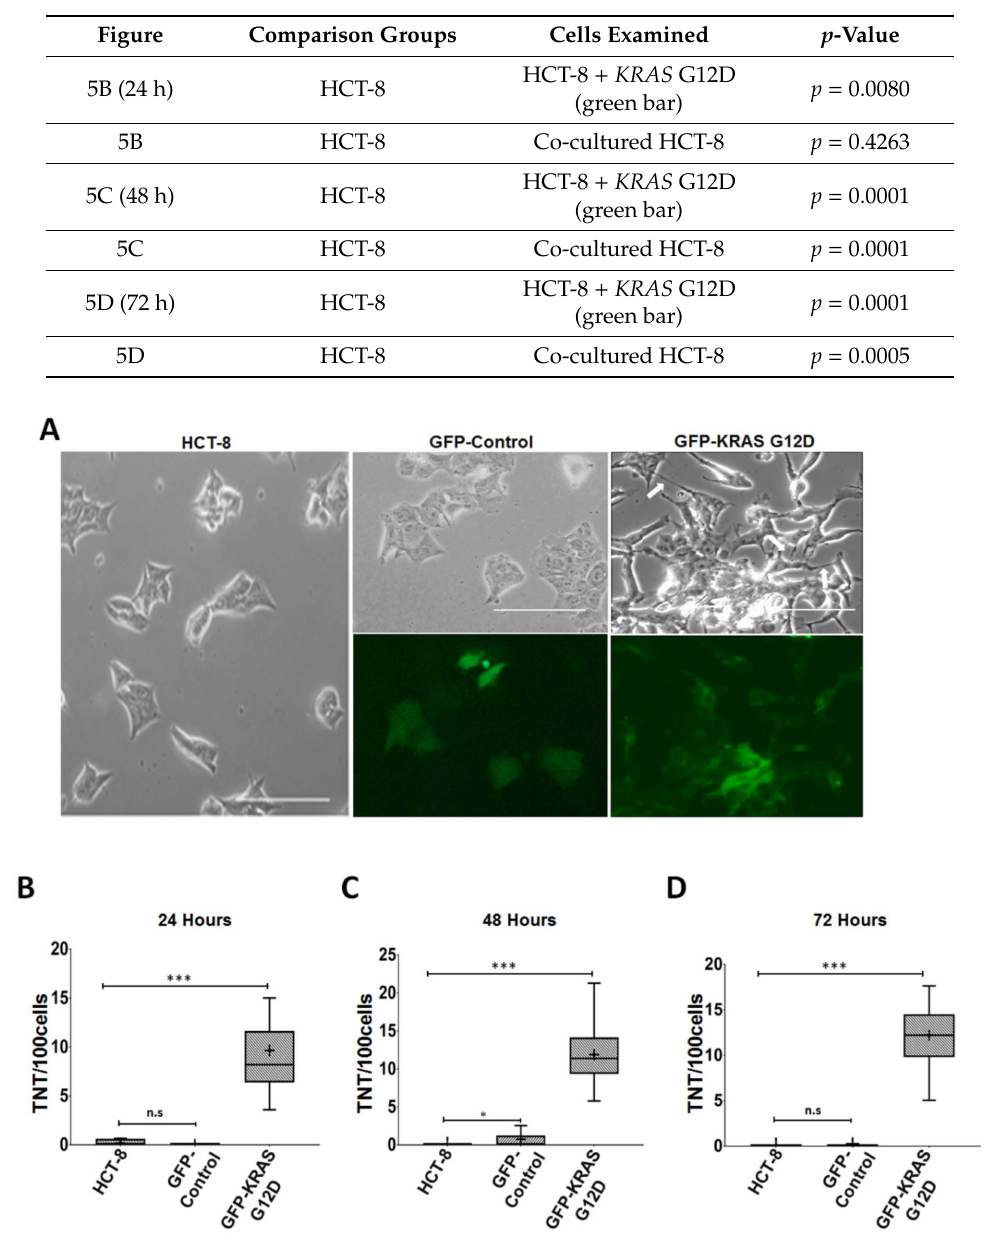
Table 2. Statistical analysis comparing HCT-8 cells either transfected with KRAS G12D or co-cultured with KRAS G12D-harboring HCT-8 cells, compared to native HCT-8 cells. t -test analysis was performed using GraphPad Prism. p -values < 0.05 were considered significant.